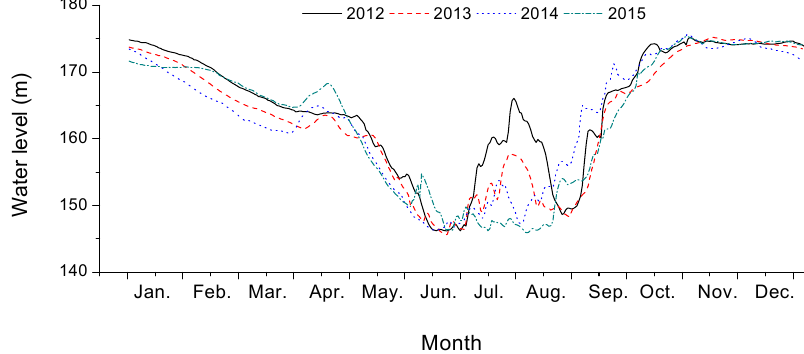
Figure 1. Water level changes of the hydro-fluctuation zone of the Three Gorges Dam Reservoir (TGDR) in Zhong County from January 2012 through December 2015.